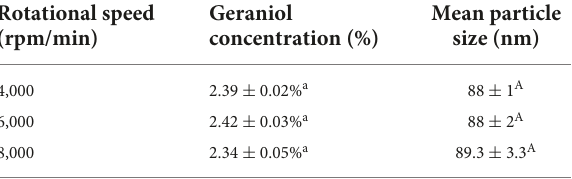
Different capital (lowercase) letters indicate significant intra-group variability, p < 0.05 ; identicalcapital(lowercase)lettersindicatesignificantinter-groupvariability, p >